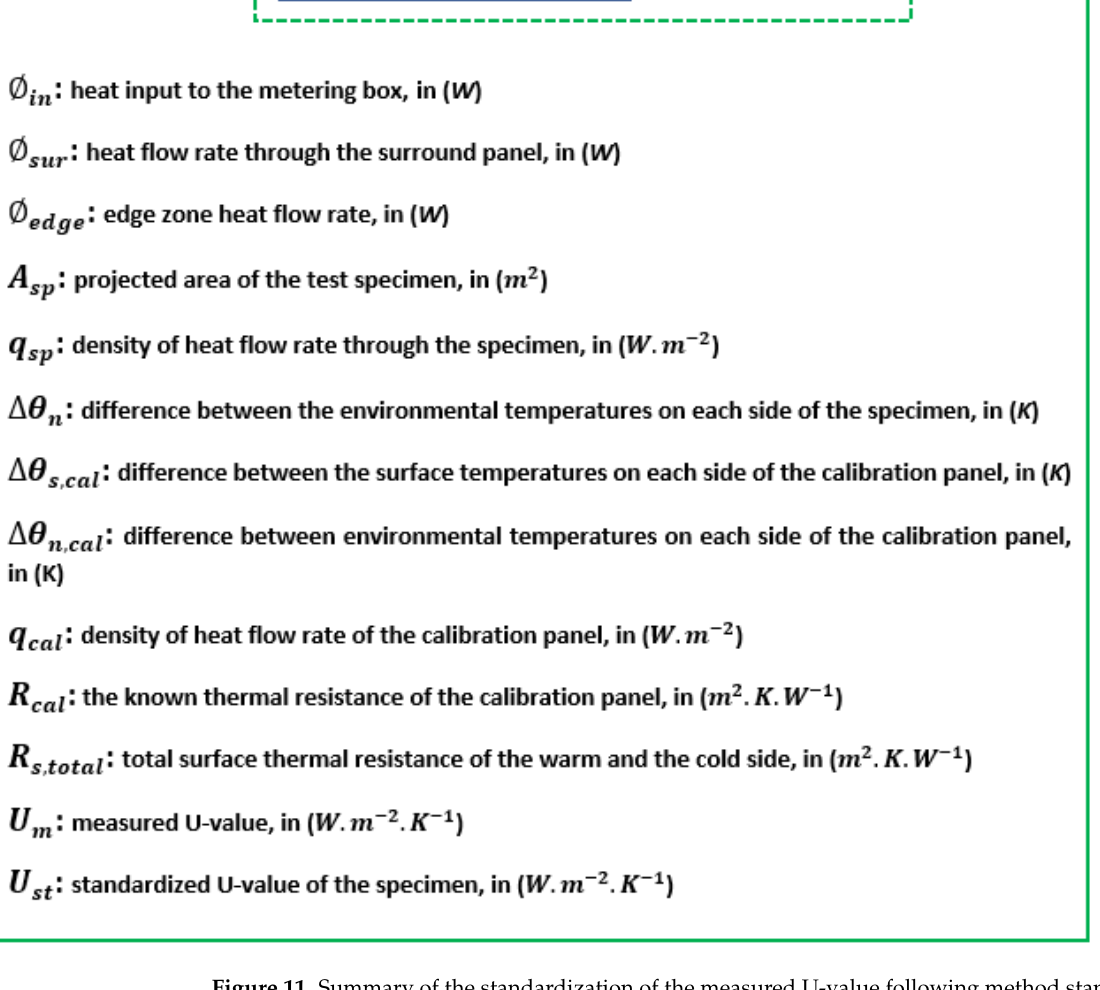
Figure 11. Summary of the standardization of the measured U-value following method standard ISO 12567: 2010.